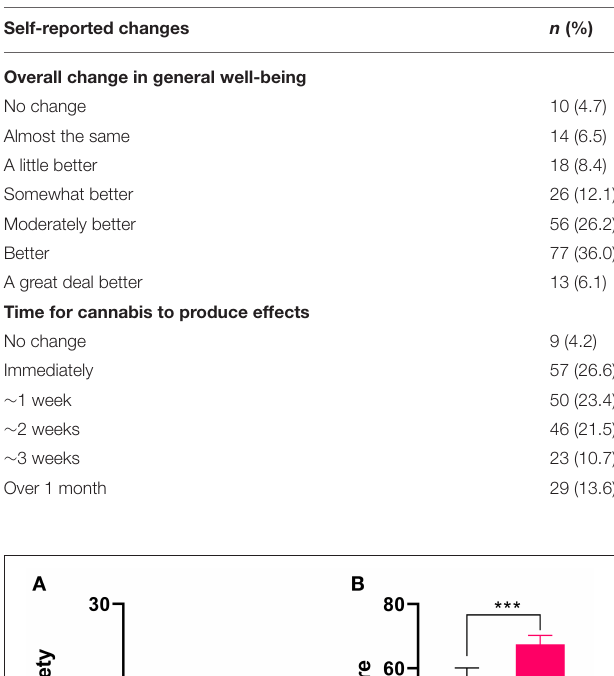
TABLE 5 | The number (and percentages) of the self-reported changes from patients after 6 weeks of medical cannabis treatment.